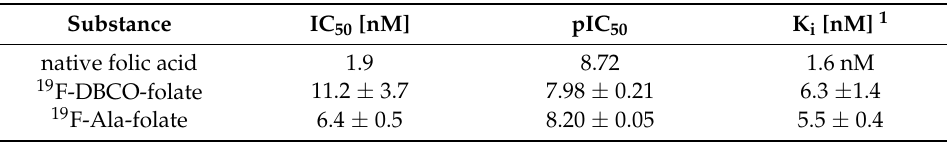
Table 3. Overview IC 50 , pIC 50 and K i values for different folates using KB-cells and [ 3 H]folic acid.